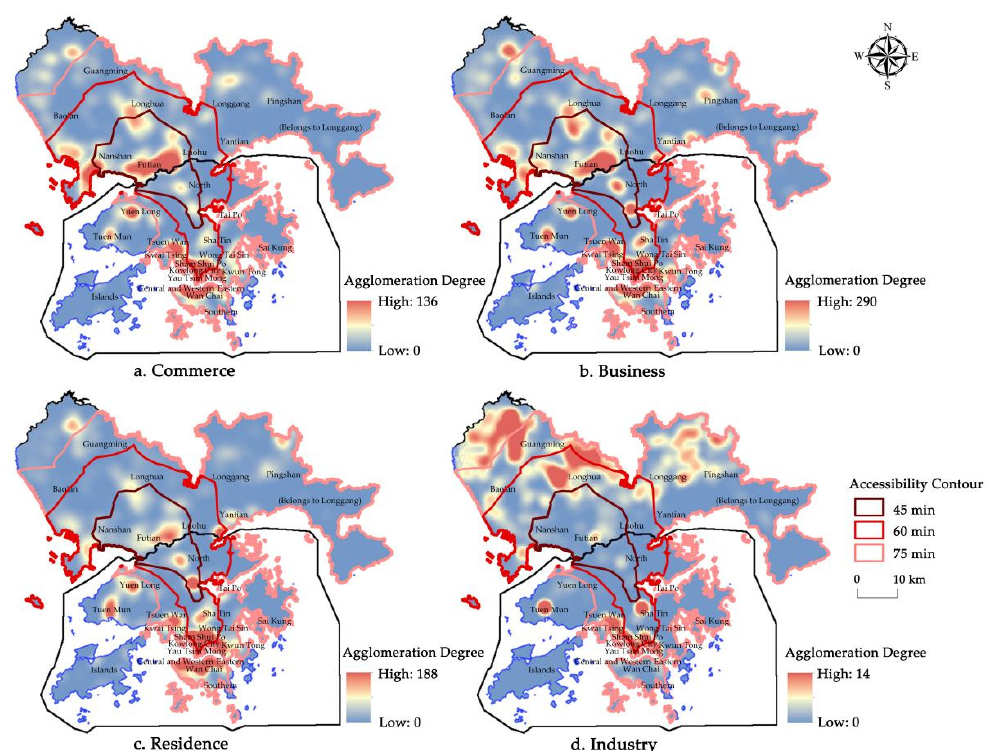
Figure 6. Spatial distribution pattern of accessibility. Note: The map is based on the standard map of the Map Technical Review Centre of the Ministry of Natural Resources of China (Number: GS (2019)4342), with no modifications to the base map; Map-making by author.